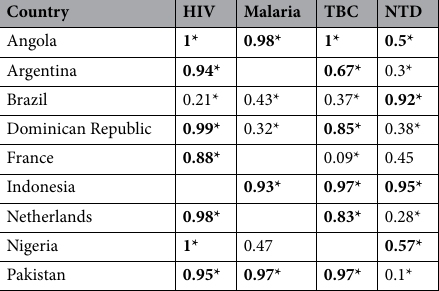
Table 5. Correlation between ESR index and the historical disease incidence for HIV, Malaria, Tubercolosis (TBC) and Tropical Neglected Diseases (NTD). Only results for the DFM appoach and for the top highly correlated countries are reported. * p val < 0.05 . Highest correlations are reported in